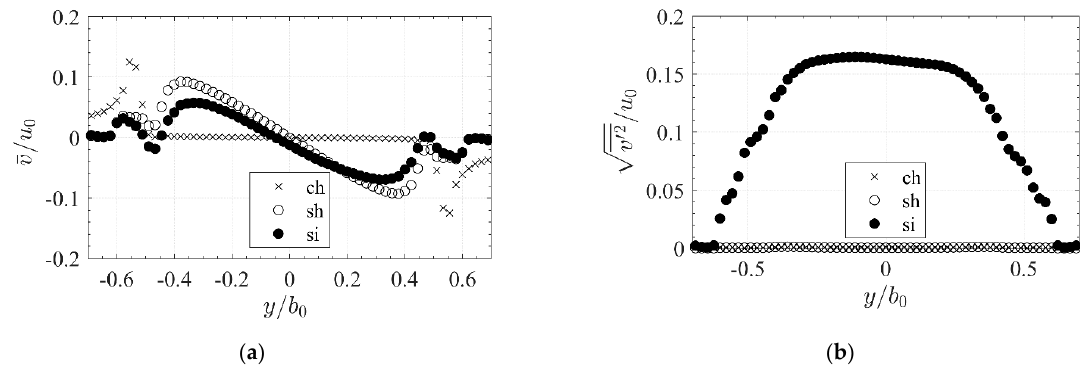
(cid:113) v (cid:48) 2 / u 0 in the